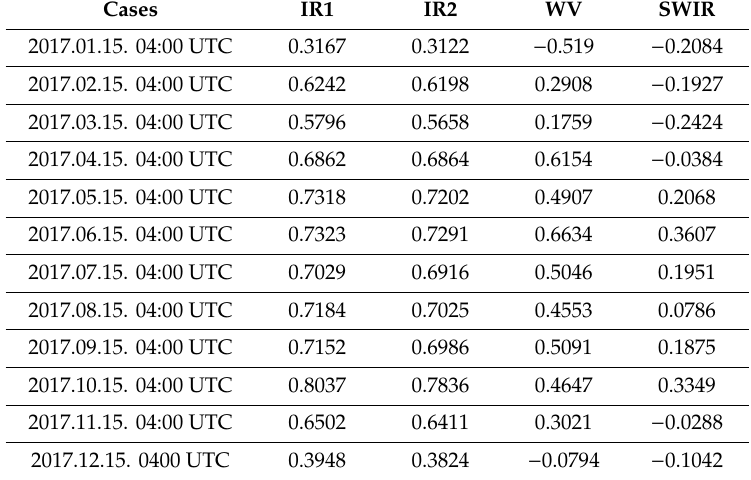
Figure 3. Images of (a) VIS reflectance, (b) water vapor (WV) radiance, (c) IR1 radiance, and (d) IR2 radiance observed from COMS / MI on June 1, 2017, 04:00 UTC (daytime). Table 2. Correlation coefficients among the COMS visible (VIS), water vapor (WV), infrared 1 (IR1), and IR2 channels.